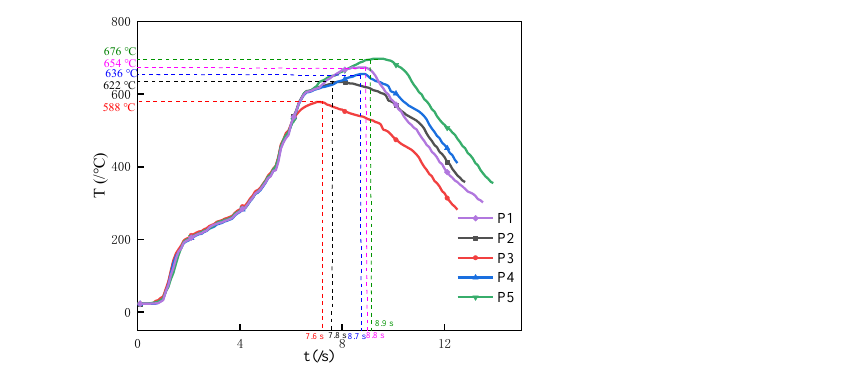
Figure 4. Combustion temperature-time distribution of Samples P1–P5 measured by a